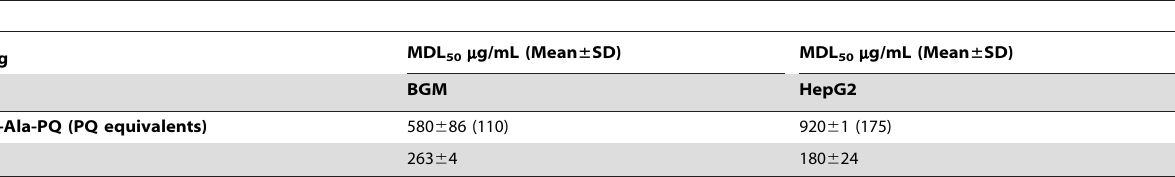
Table 2. Cytotoxicity of Phe-Ala-PQ and PQ against a human hepatoma cell line (HepG2) and a monkey kidney cell line (BGM) determined by the MTT assay.